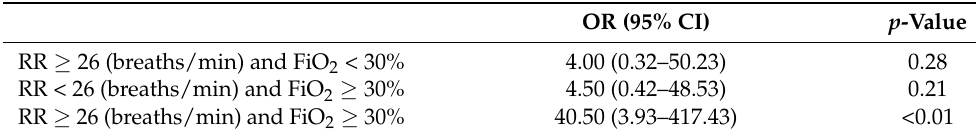
Table 8. The combination of respiratory rate and fraction of inspiratory oxygen for predicting clinical